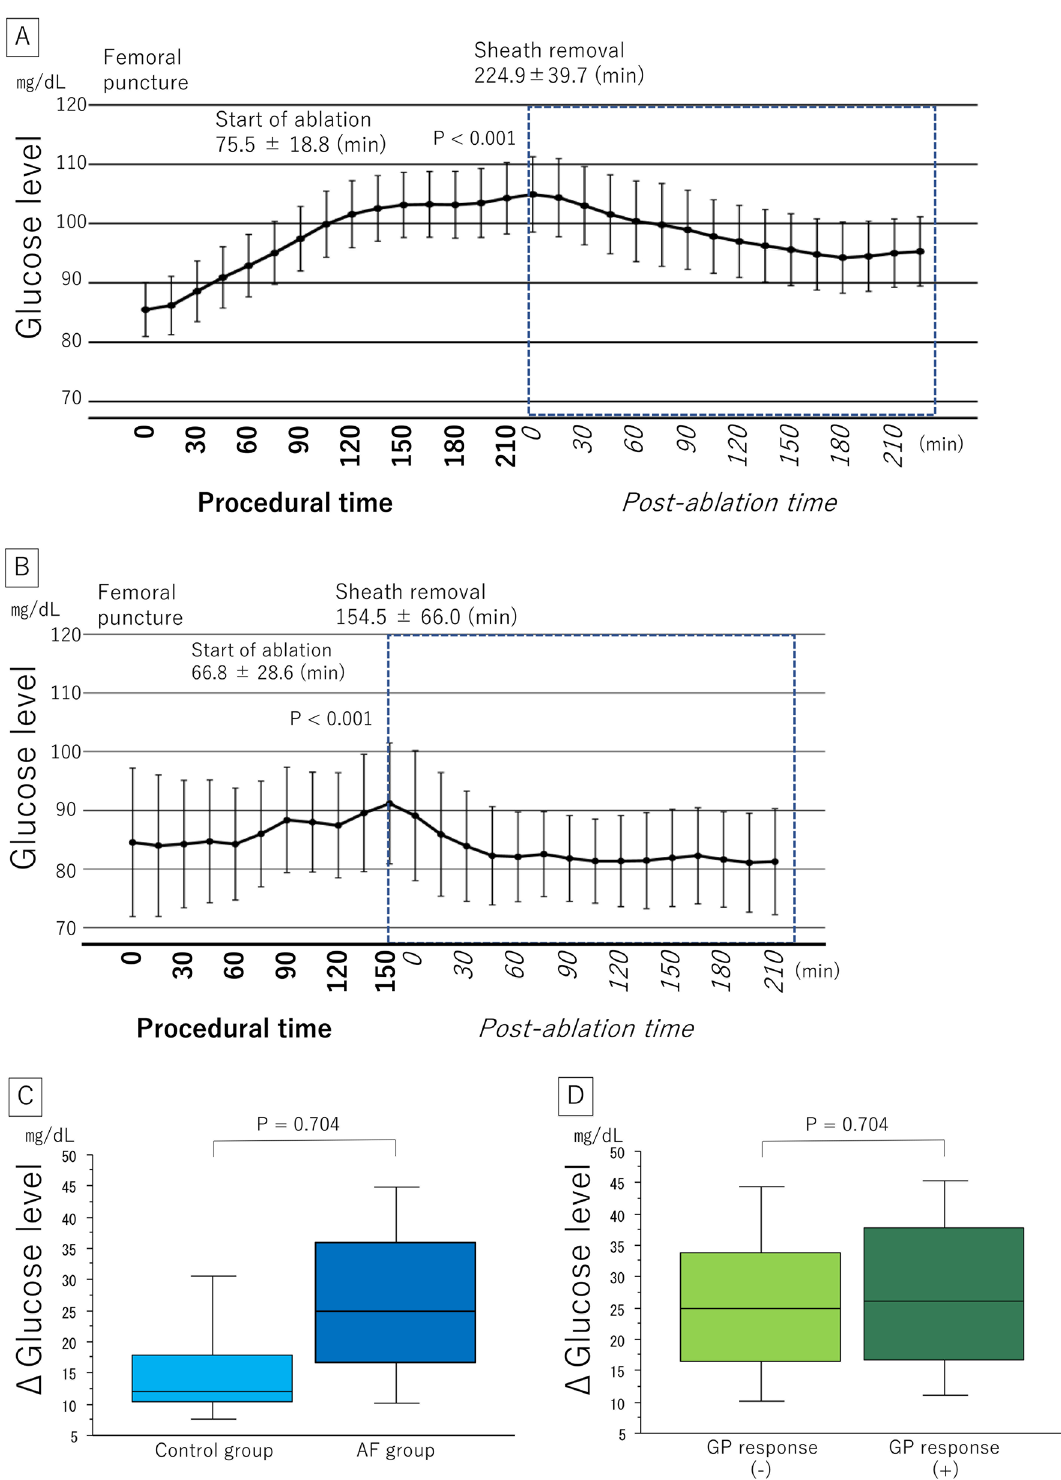
Figure 1. ( A , B ) Interstitial glucose levels during and after the procedure in the AF group and the control group. ( C ) The Δ glucose level (maximum minus minimal) during the procedure in the AF and control groups. Time zero was defined as the time of femoral puncture. The mean time from femoral puncture to the start of ablation was 75.5 ± 18.8 min in the AF group and 66.8 ± 28.6 min in the control group. The mean time from femoral puncture to sheath removal was 224.9 ± 39.7 min in the AF group and 154.5 ± 66.0 min in the control group. ( D ) The Δ glucose level in patients with and without GP responses. AF atrial fibrillation, GP ganglionated